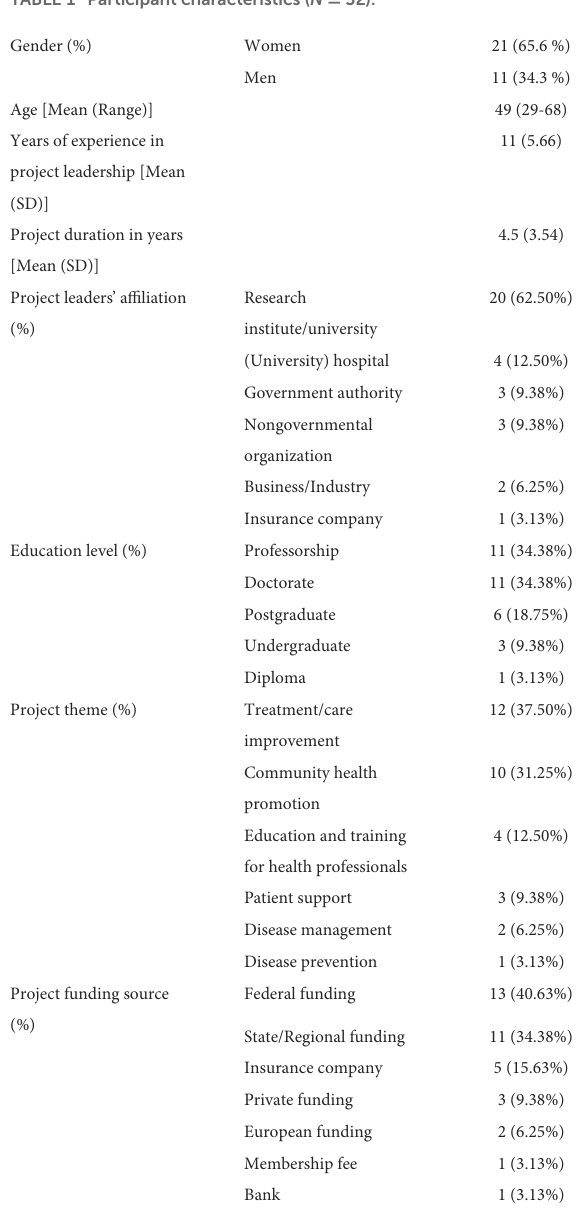
TABLE 1 Participant characteristics ( N =